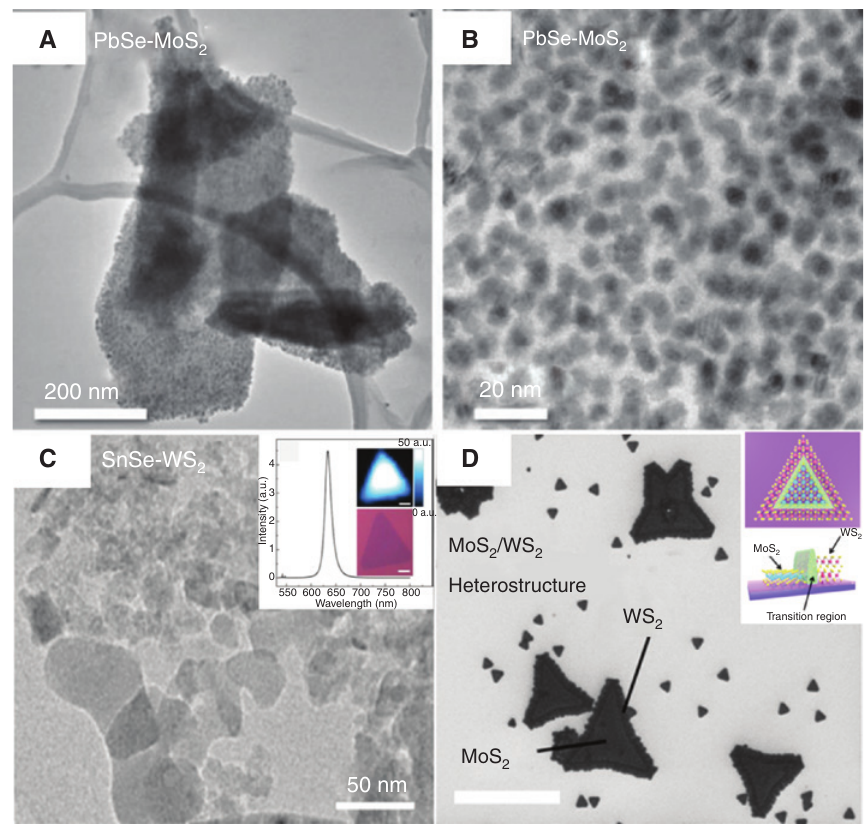
; (B) HRTEM image of the PbSe-MoS hybrid material showing the average size of 2 2 grown by CVD Inset: 2 monolayer. The scale bar indicates 5 μ m [17]. (D) SEM image of CVD grown hetero- 2 /MoS in-plane heterojunctions 2 2